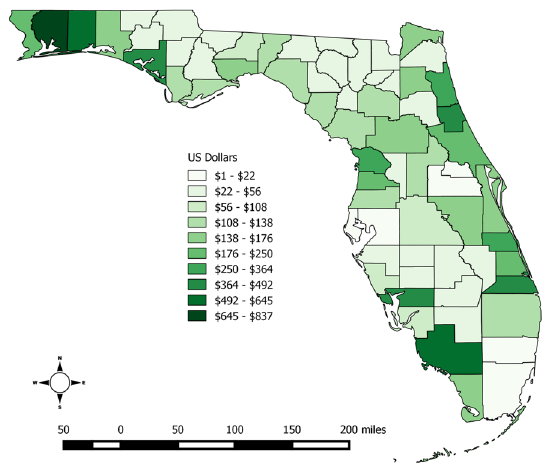
Figure 3. Individual WTP by counties for an improvement from level 5 (fishable) to level 7 (swimmable) in the state of Florida.